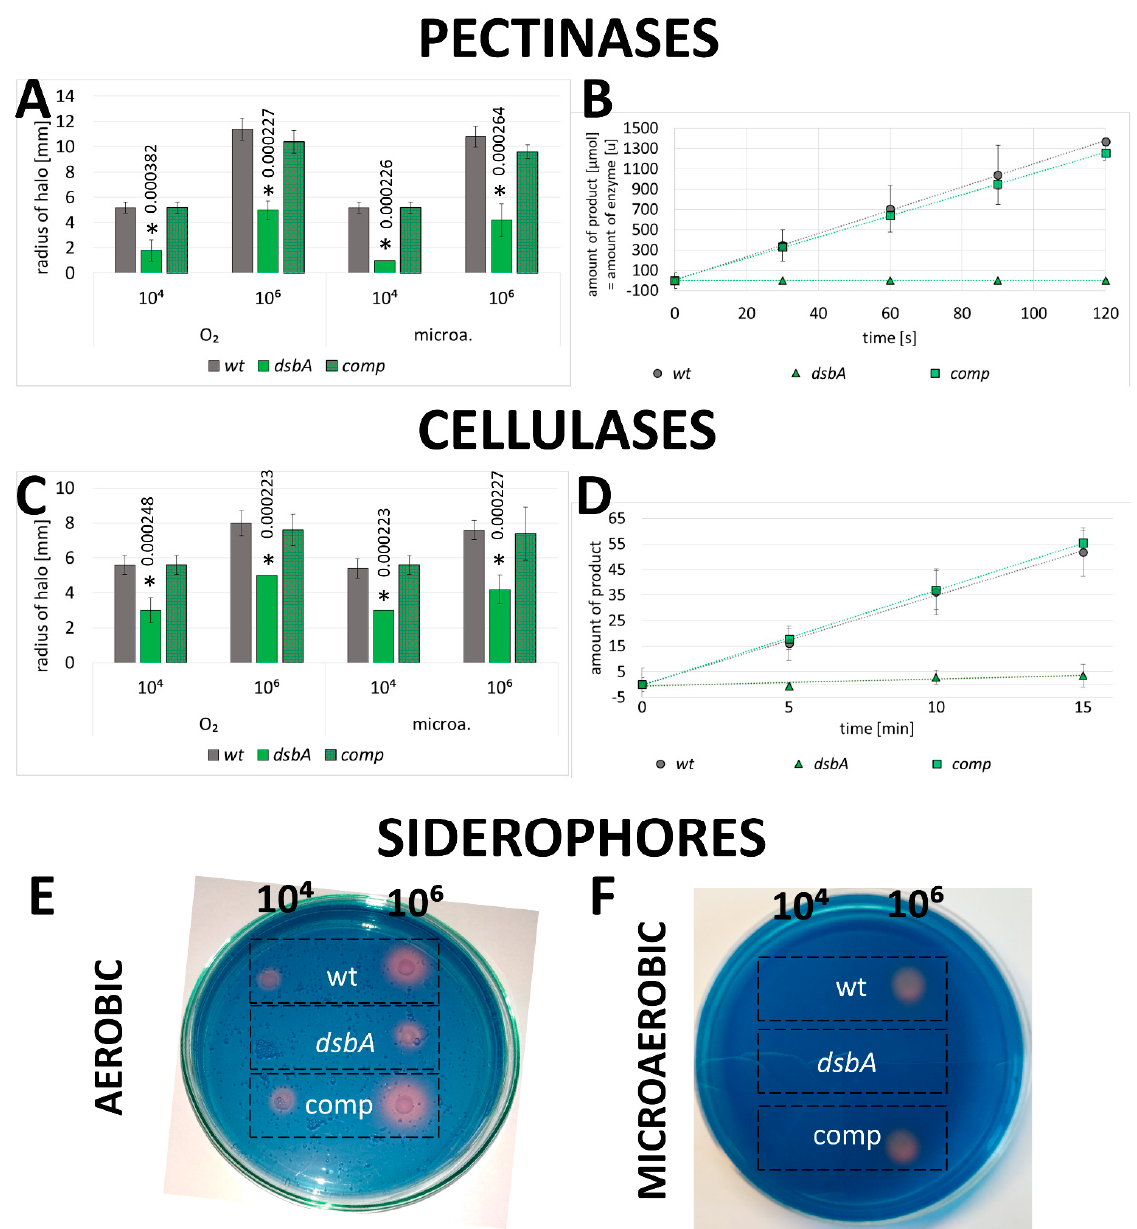
Figure 3. Impact of the dsbA knockout on the secreted virulence factors of D. solani : ( A , B ) pectinolytic activity, ( C , D ) cellulolytic activity and ( E , F ) siderophore secretion. Panels A and C show the mean values of the halo radii determined by plate assays. The statistical analysis of differences was determined by two-way analysis of variance (ANOVA) test followed by a post hoc Tukey test. The asterisks indicate statistical significance ( p < 0.001); the numbers next to asterisks show the actual p -values. B and D —spectrophotometric determination of the enzymes’ activity in culture supernatants. Error bars represent SD from five experimental repetitions. Representative examples of Chromo-Azurol stained plates used to detect siderophore production are shown in E , F . In every assay, five independent replicates of each strain were analyzed. Abbreviations: wt—wild-type strain; dsbA — mutant strain TP02; comp—complemented strain TP03.